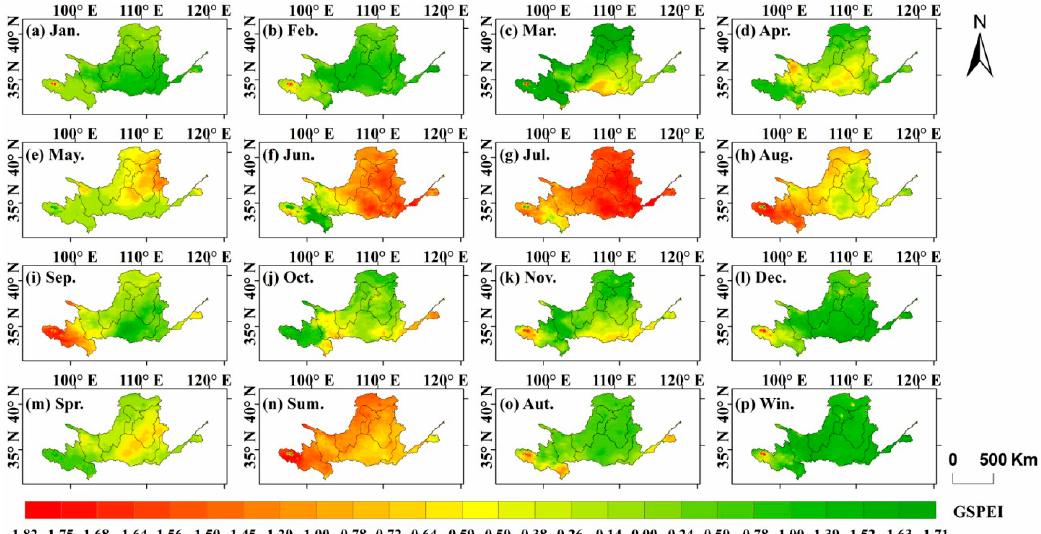
Figure 7. Spatial distribution of drought in the Yellow River basin (YRB). ( a – p ) denote January, February, March, April, May, June, July, August, September, October, November, December, Spring, Summer, Autumn, and Winter, respectively (similar